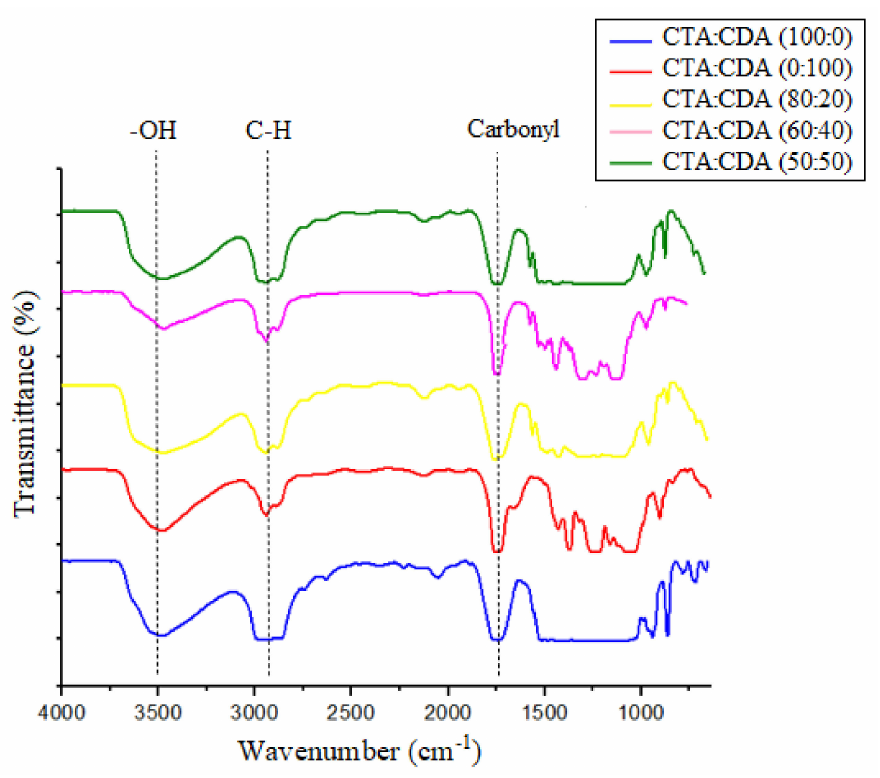
Figure 2. FTIR spectrum of fabricated membranes.